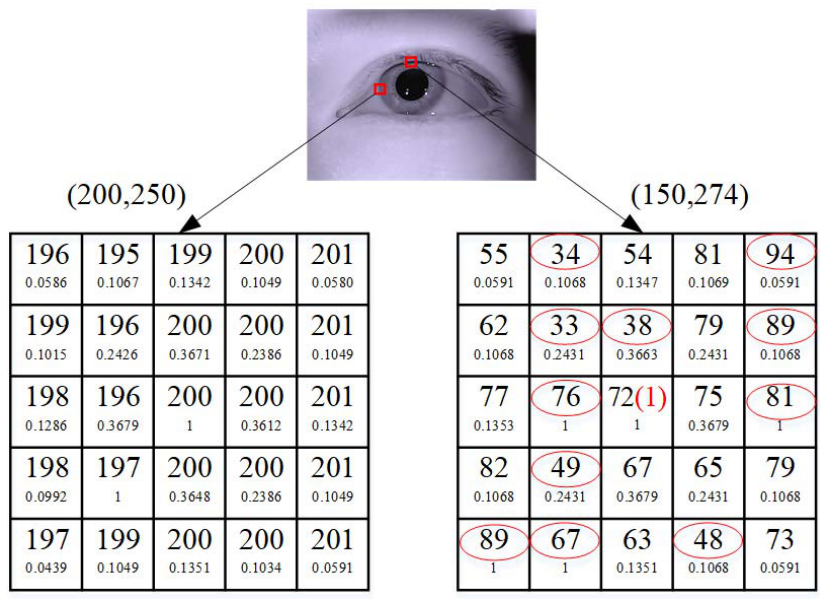
Figure 6. Example of local window filtering.